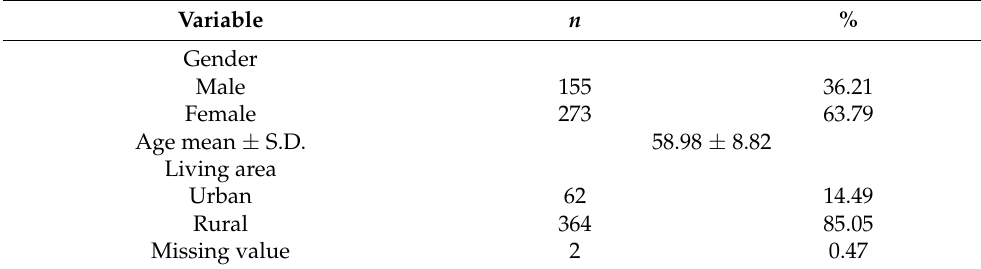
Table 1. Basic socio-demographic characteristics (2011, n =